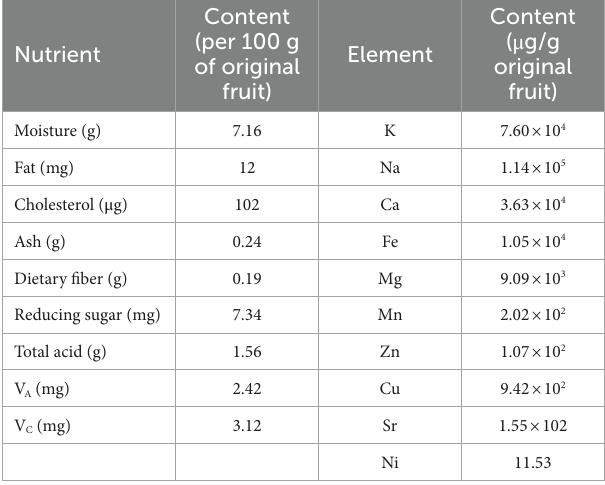
TABLE 1 General nutrient and trace element content in cistanche. Nutrient